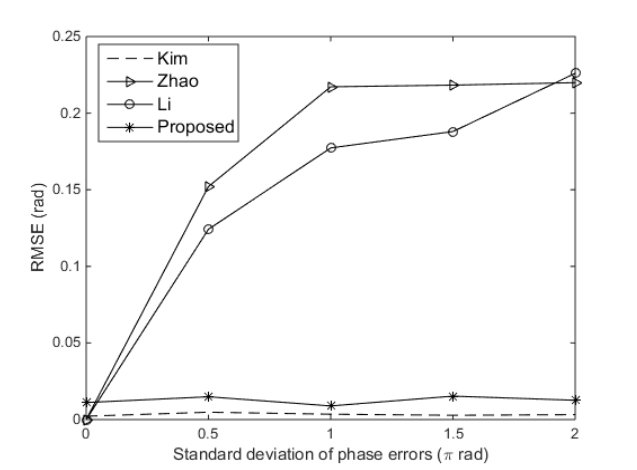
Figure 7. RMSE versus the standard deviation of phase